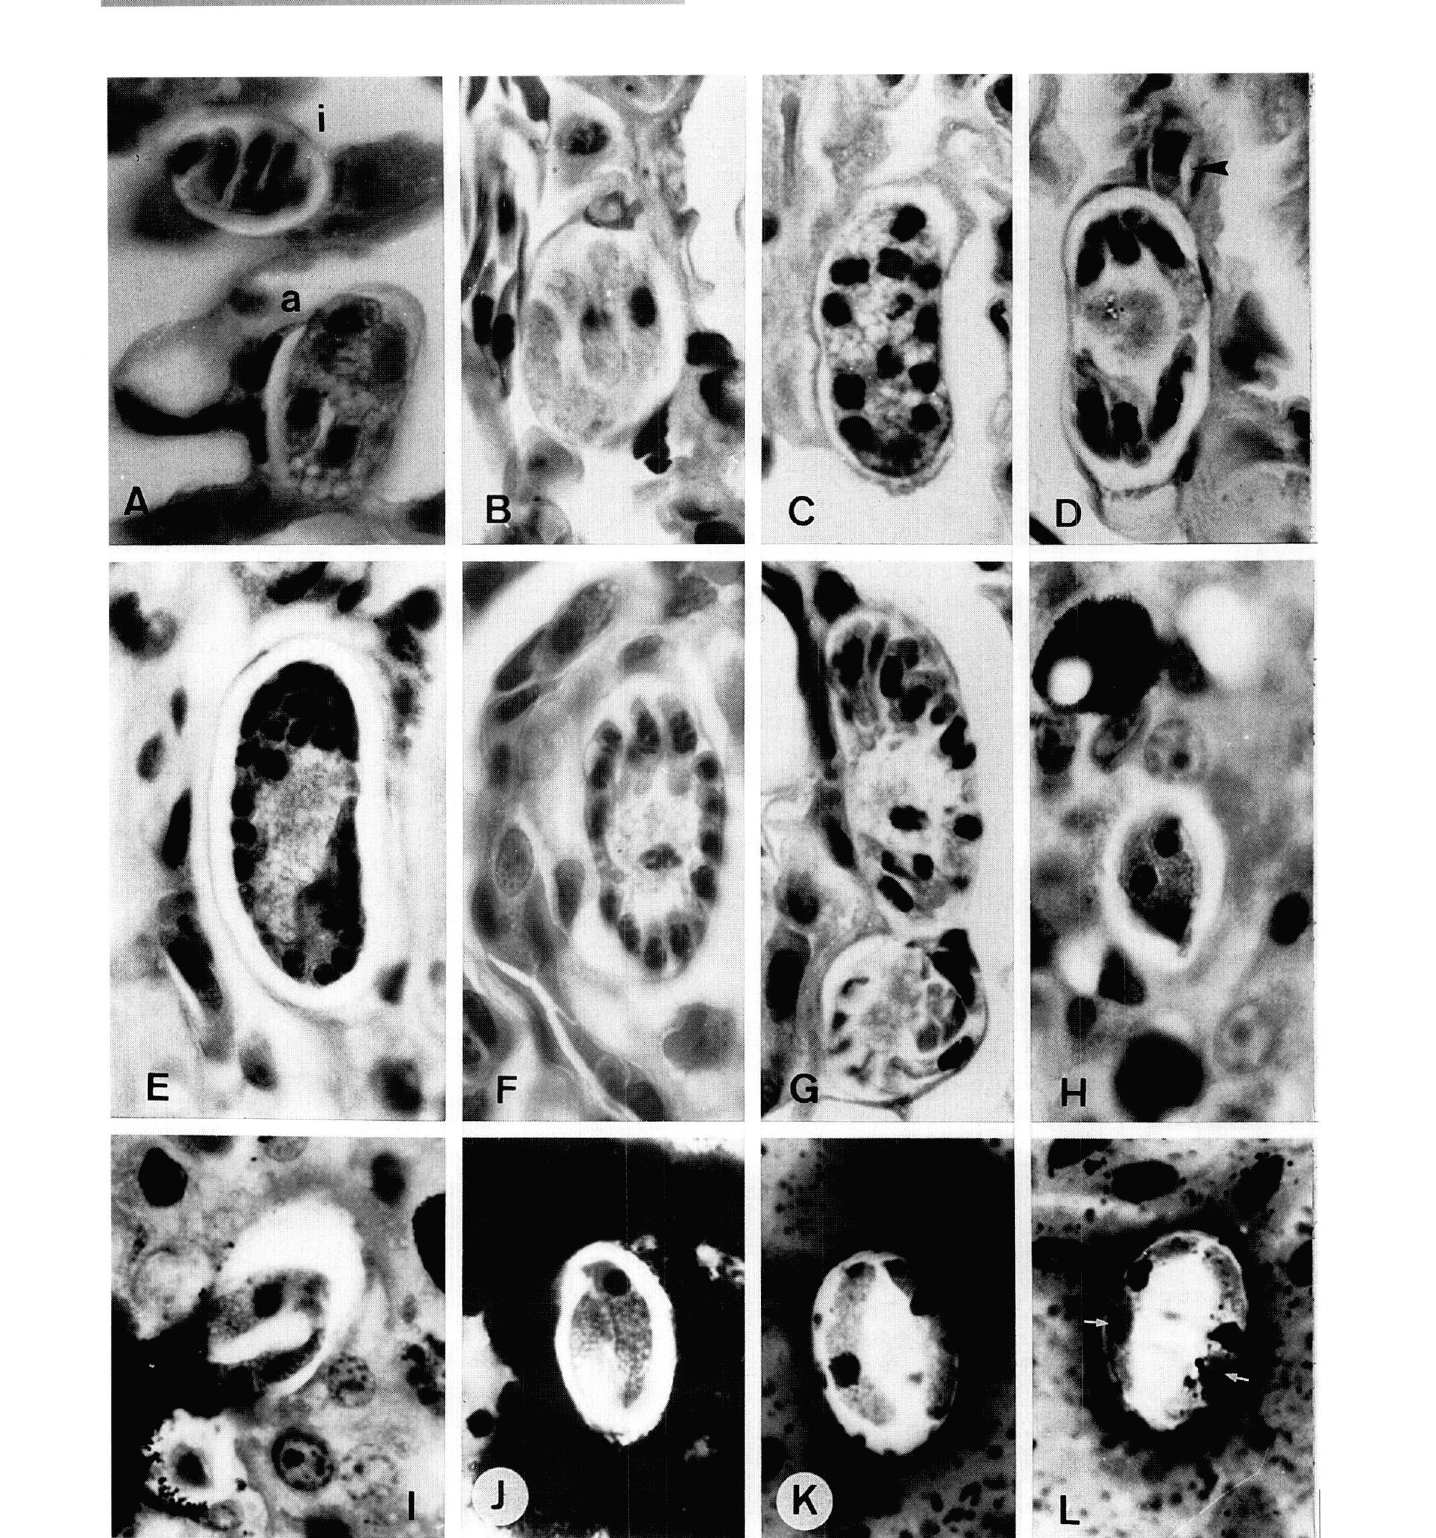
Fig.1. - Merogonic stages of Hepatozoon kisrae n.sp. from lungs and liver of Agama stellio (x 1,300). A-G, stages in lungs: A. macrome- ronts in division (a) and divided micromeronts (i); B. Macromeronts after division; C. Macromeronts prior division; D. Post-division macro- meront formation; E. Micromeronts prior division; F,G. Post division micromeront formations. H-L: Dizoic cyst-type meronts in the liver (L, merozoites show blue-staining crystalline-like bodies, marked with arrows).